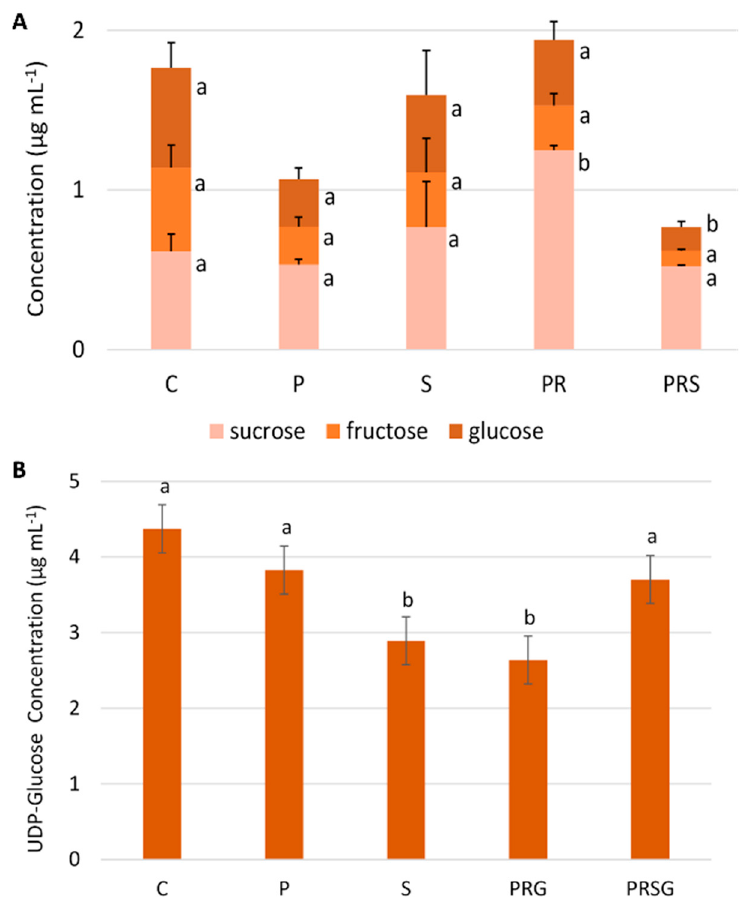
Figure 4. Content of main sugars in pollen samples: ( A ) concentration of sucrose, glucose, and fructose in control sample (C), primed sample (P), stressed sample (S), primed + recovery sample (PR) and primed + recovery + stress sample (PRS). Points with the same lower-case letters do not differ significantly ( p > 0.05); ( B ) concentration of UDP-glucose. Concentration is expressed as μ g/mL.